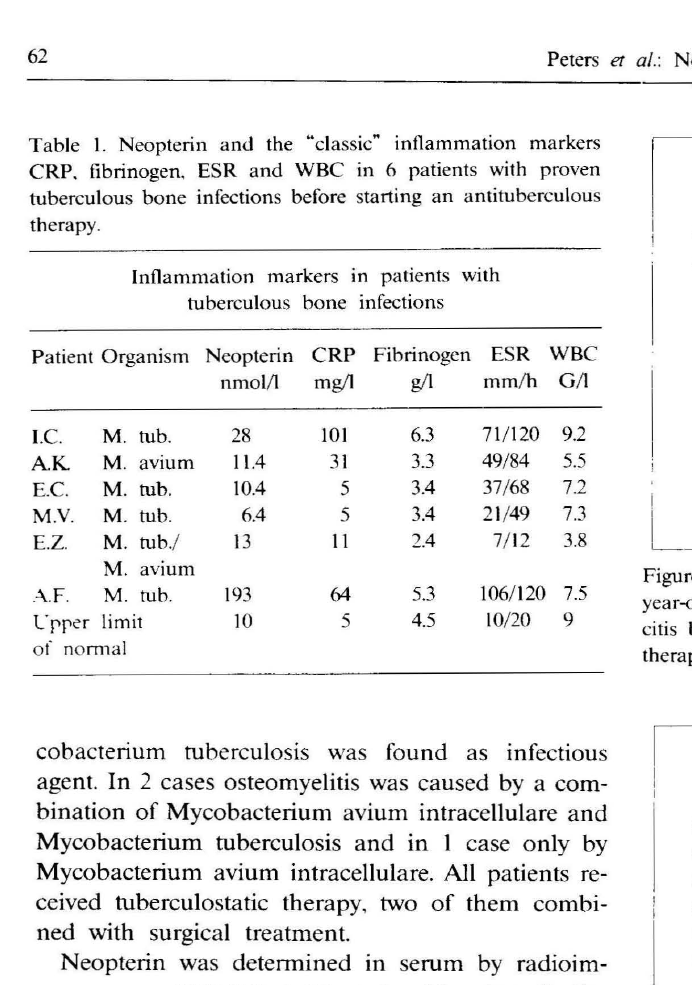
Figure I. Levels of neopterin. CRP and fibrinogen in a 38- year-old patient (I.e.) suffering from tuberculous spondylodis citis before and after combined surgical and antituberculous therapy.